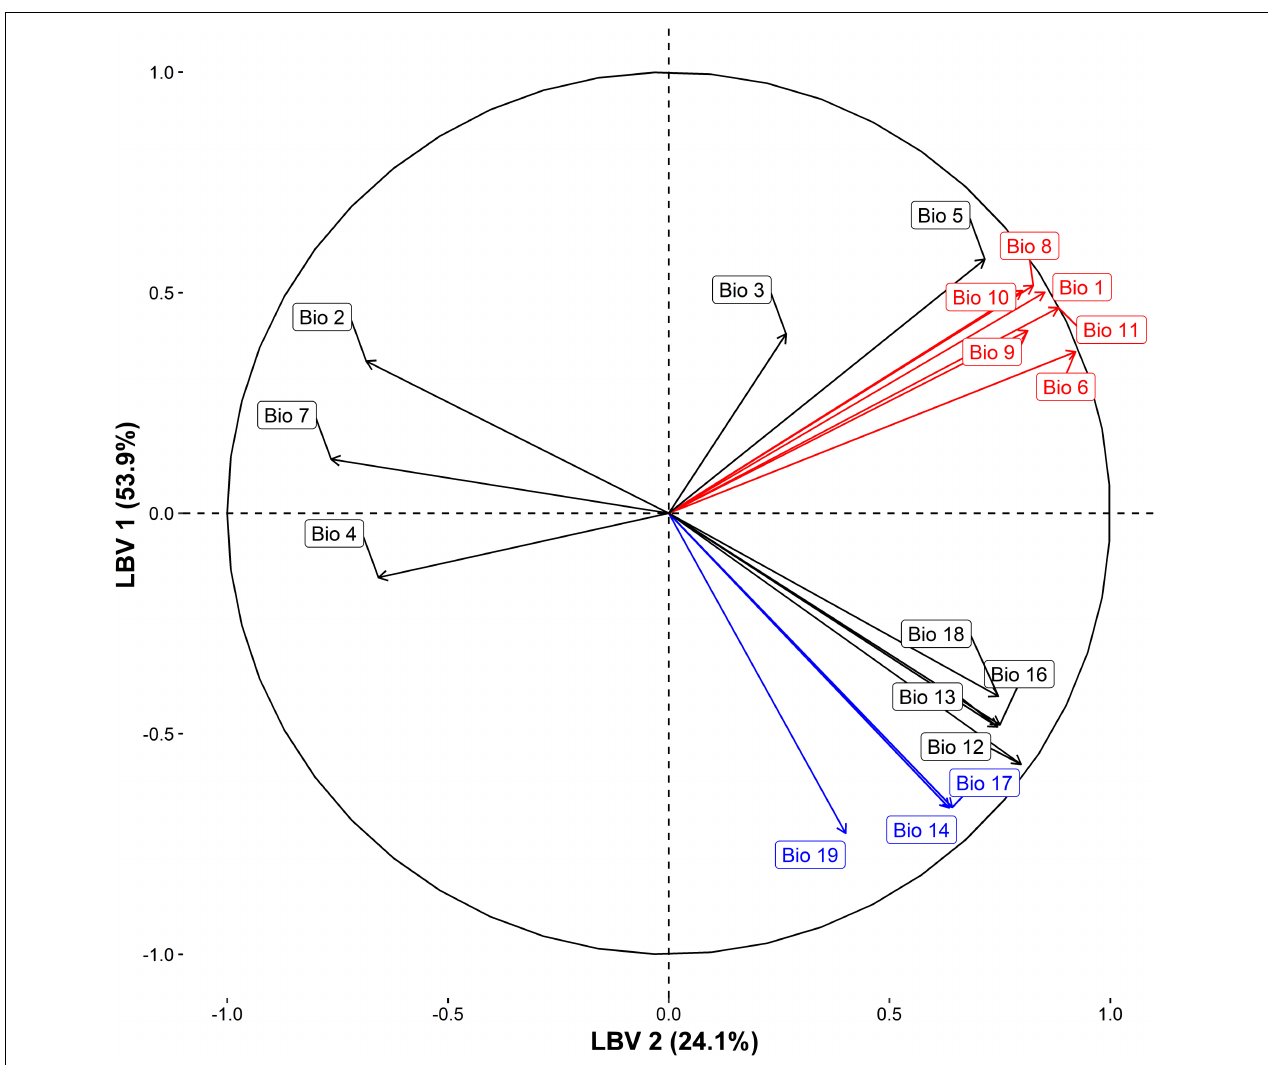
FIGURE 2 | Correlation plot of 18 bioclimatic variables. X- and y-axis correspond to the first two components obtained from principal component analyses of the original bioclimatic variables. Principal components are used as so-called “latent” (unobserved) variables (Dormann et al., 2013) and are referred to as latent bioclimatic variables (LBVs). Direction of variables show associations with LBV1 and LBV2. Distances to the correlation circle indicate how well a variable is represented by LBV1 and LBV2. Bioclimatic variables were taken from the CHELSA online database (chelsa-climate.org; Karger et al., 2017, 2018) and were extracted for Peru, Chile and